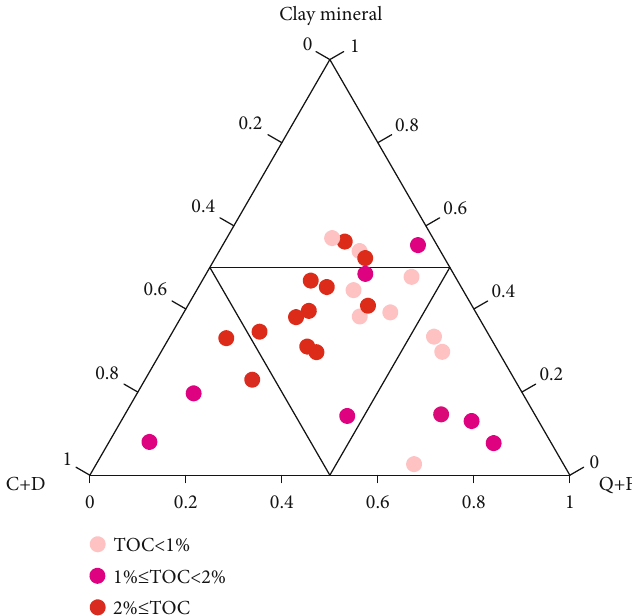
Figure 2: Shale sample mineralogical composition ternary